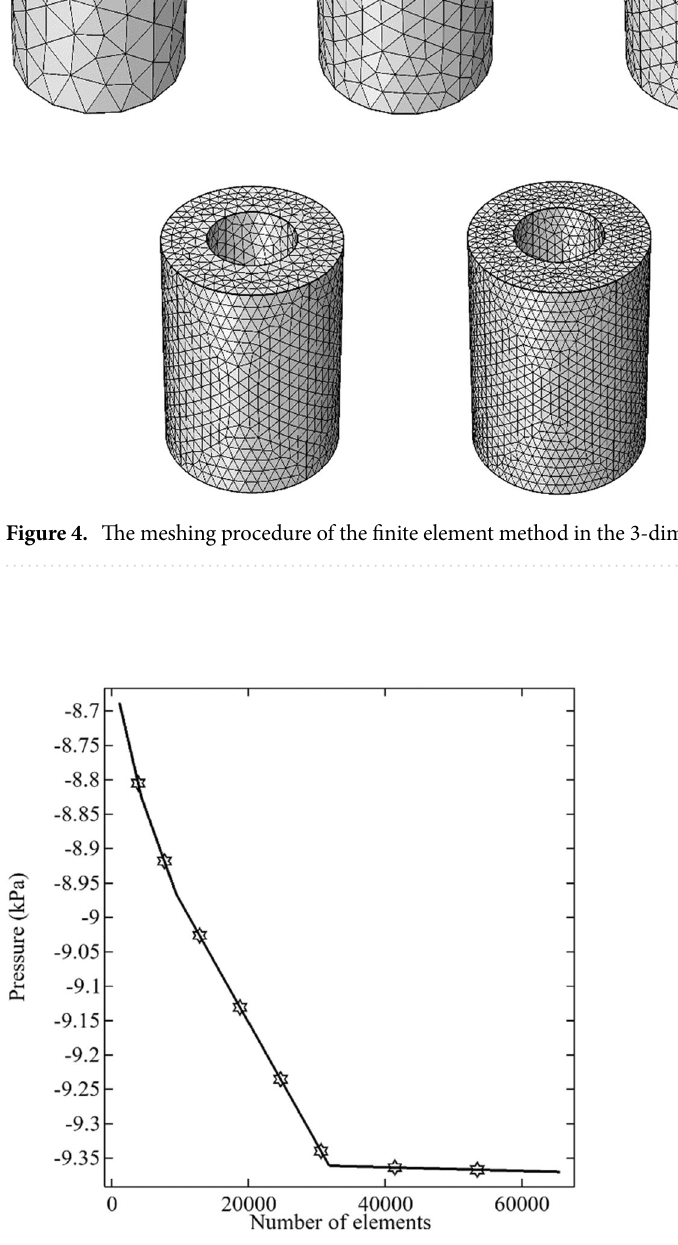
Figure 5. The mesh independency test for the pressure at the outlet of the